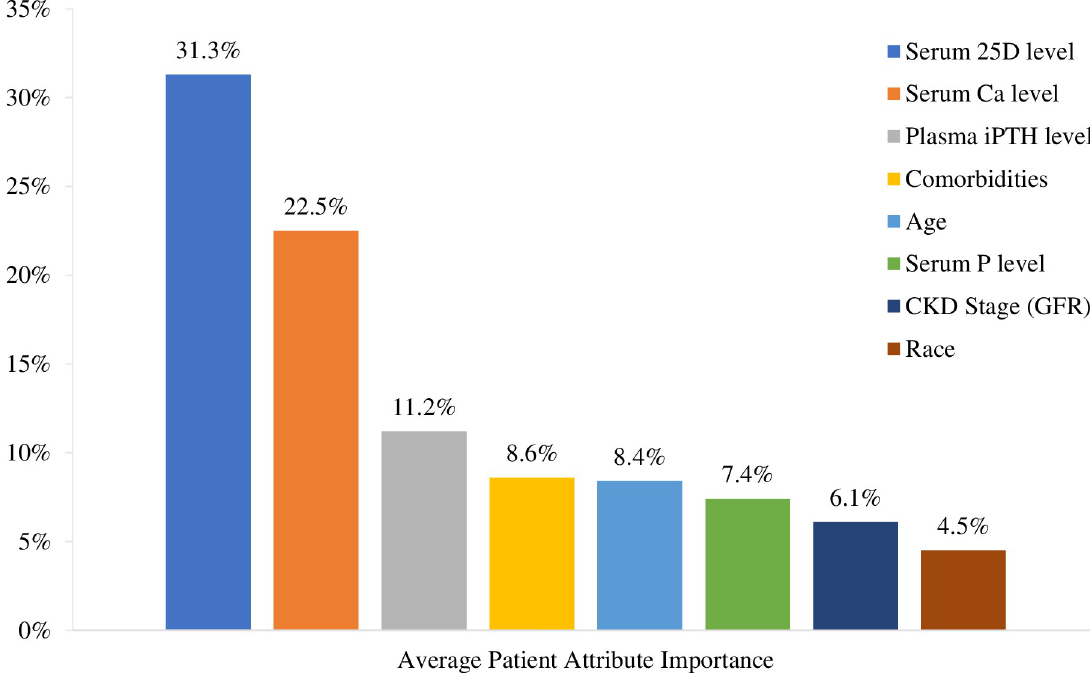
Fig 2. Average patient attribute importance. Factors that trigger treatment for VDI and SHPT in patients with pre-dialysis CKD stage 3–5; ordered by relative importance as indicated by conjoint analysis part-worth utilities.